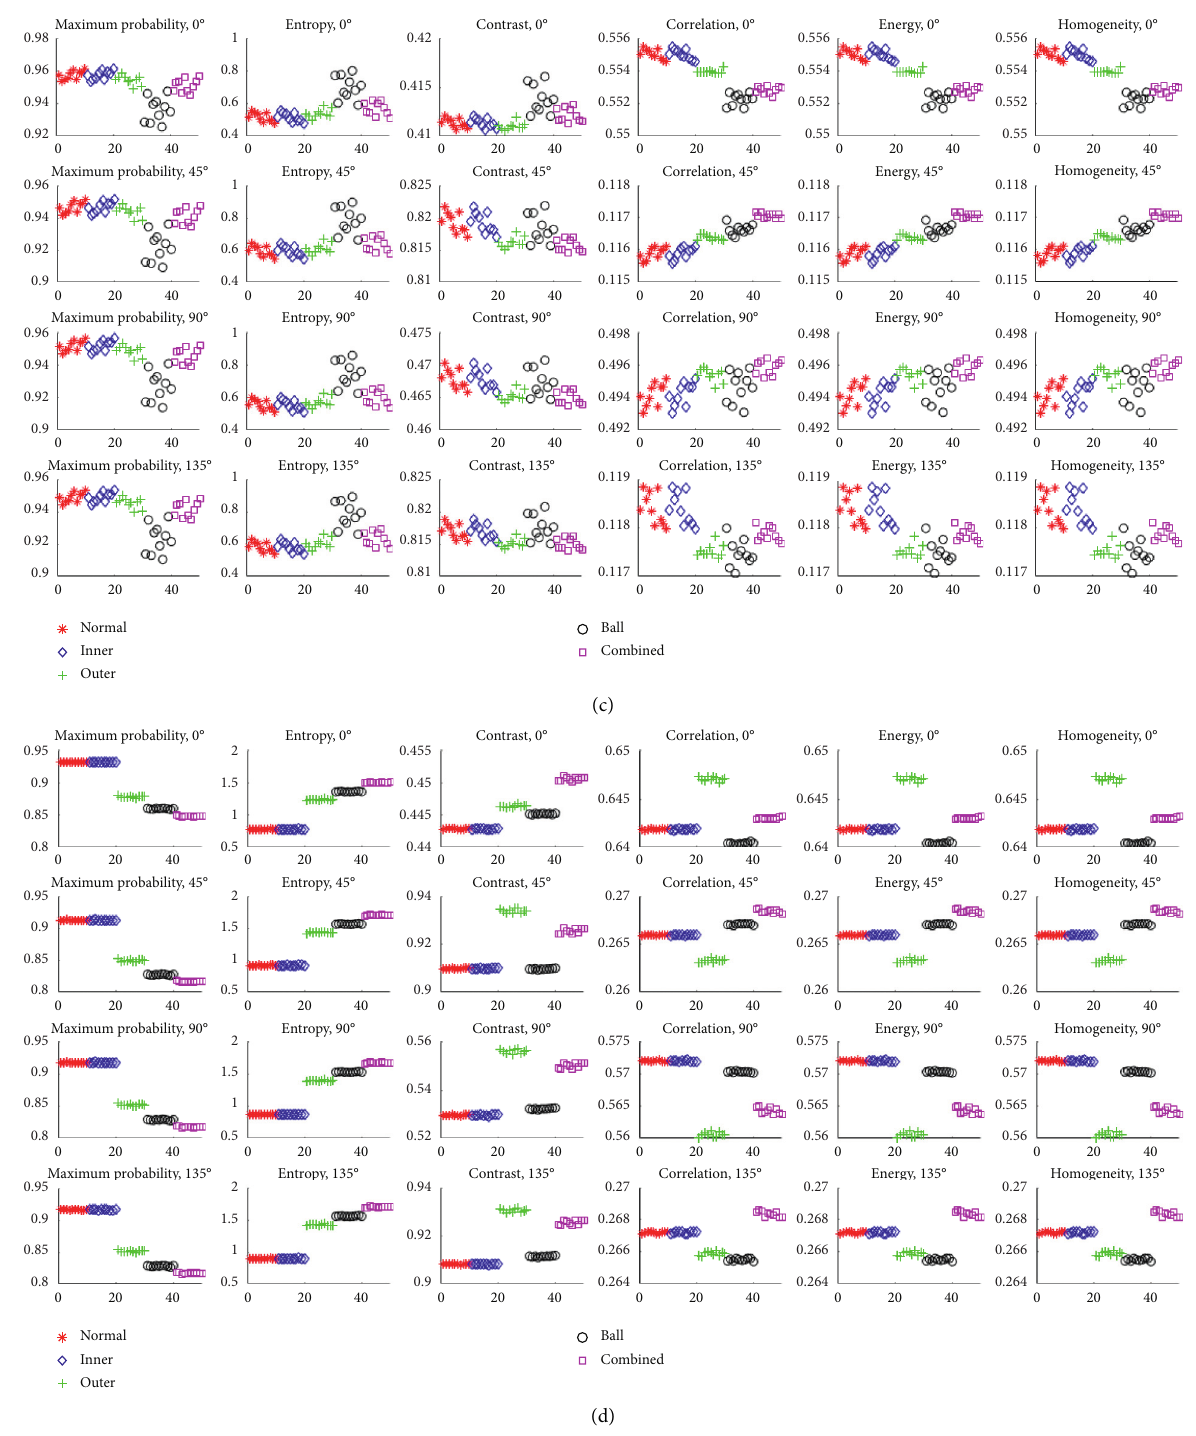
Figure 11: Distribution of 24 statistical feature parameters (SFPs) obtained by (a) STFT, (b) SST, (c) OSST, and (d)